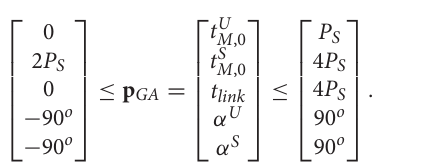
Frontiers in Applied Mathematics and Statistics |